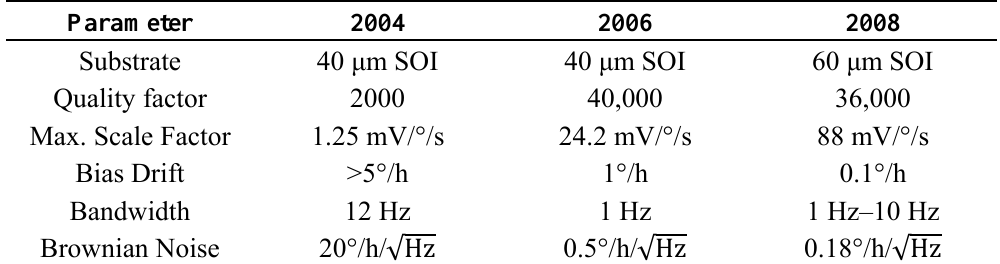
Table 1. The improvement of the Georgia Tech